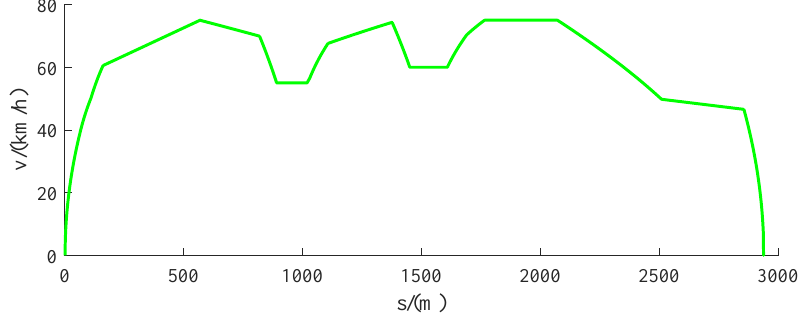
Figure 13. Target speed curve of urban rail